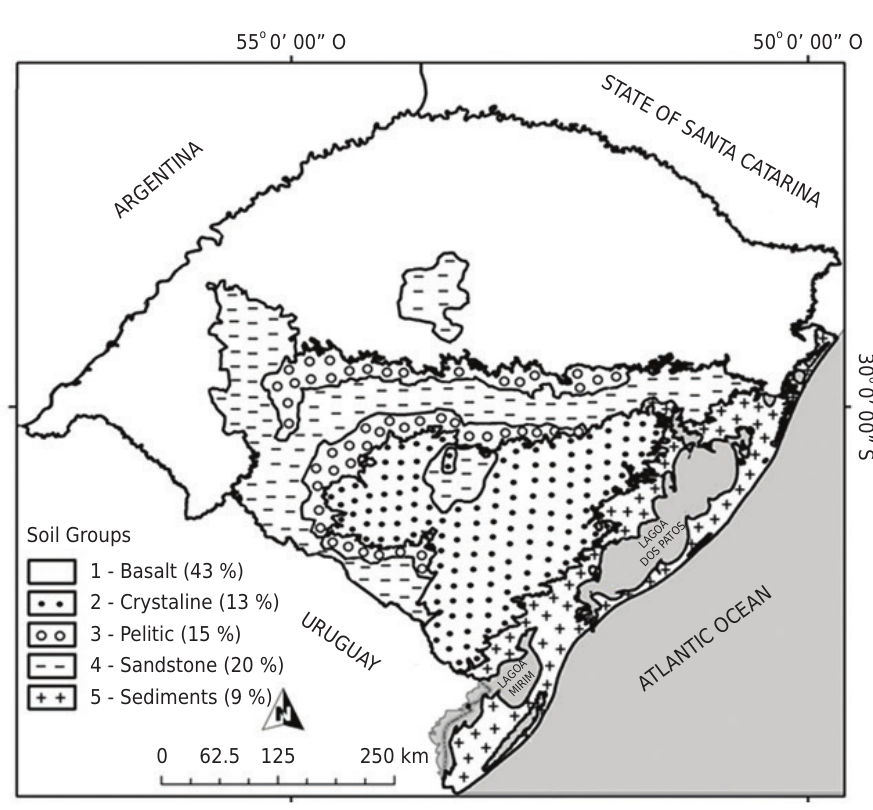
Figure 1. Map of soil groups of the state of Rio Grande do Sul (Brazil) according to soil parent material, based on the geological map (CPRM, 2006) and on the geomorphological province map (Streck et al., 2008). Source: Adapted from Fepam (2014).